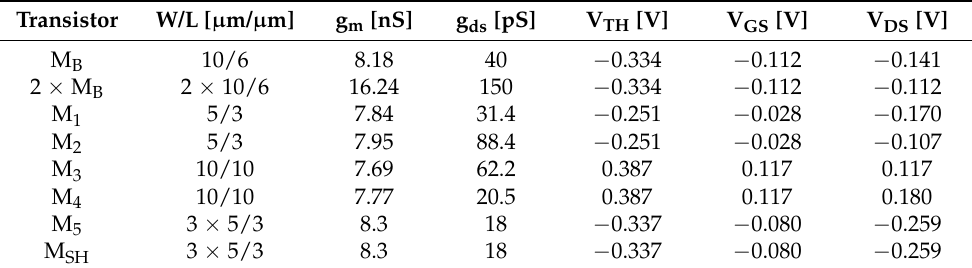
Table 1. Simulated OP parameters of transistors ( I B = 250 pA, V DD = 0.4 V, T = 27 °C). Transistor